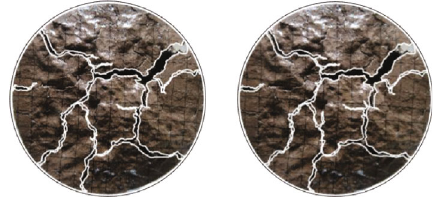
Figure 9: Stabilization stage.